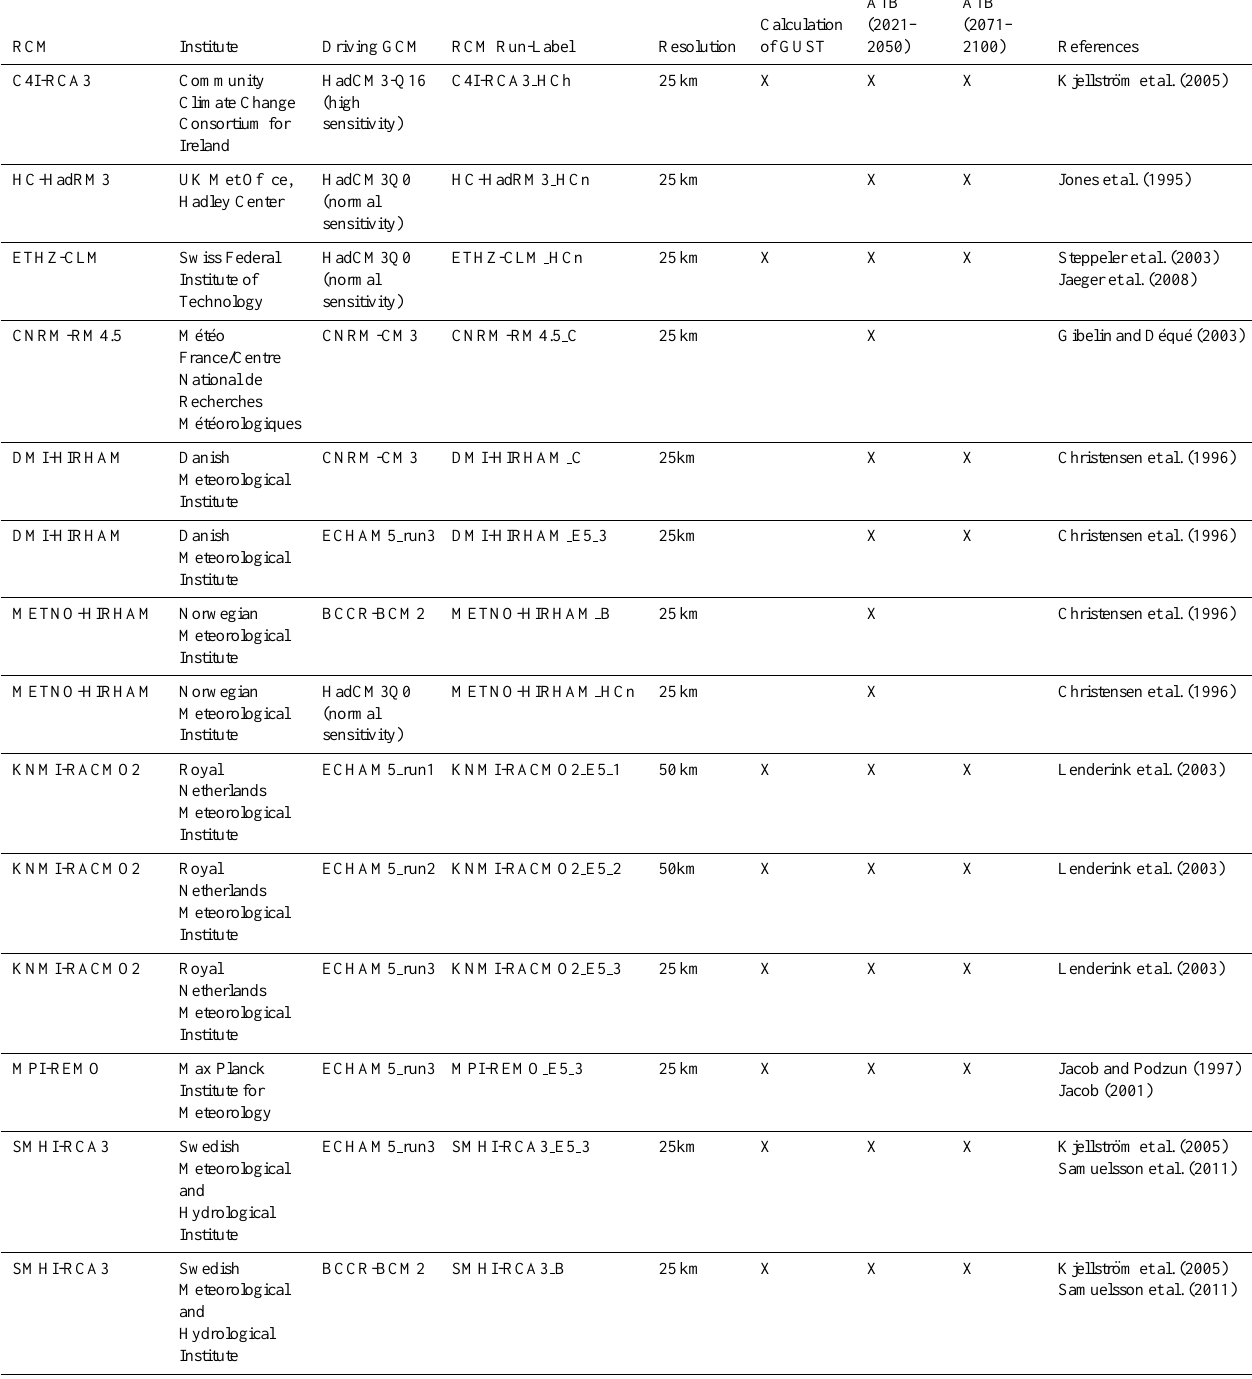
Table 1. b RCM scenario simulations; the RCM run-labels (as referenced in the text) consist of the abbreviations for the modelling institution, the particular RCM and a code for the driving